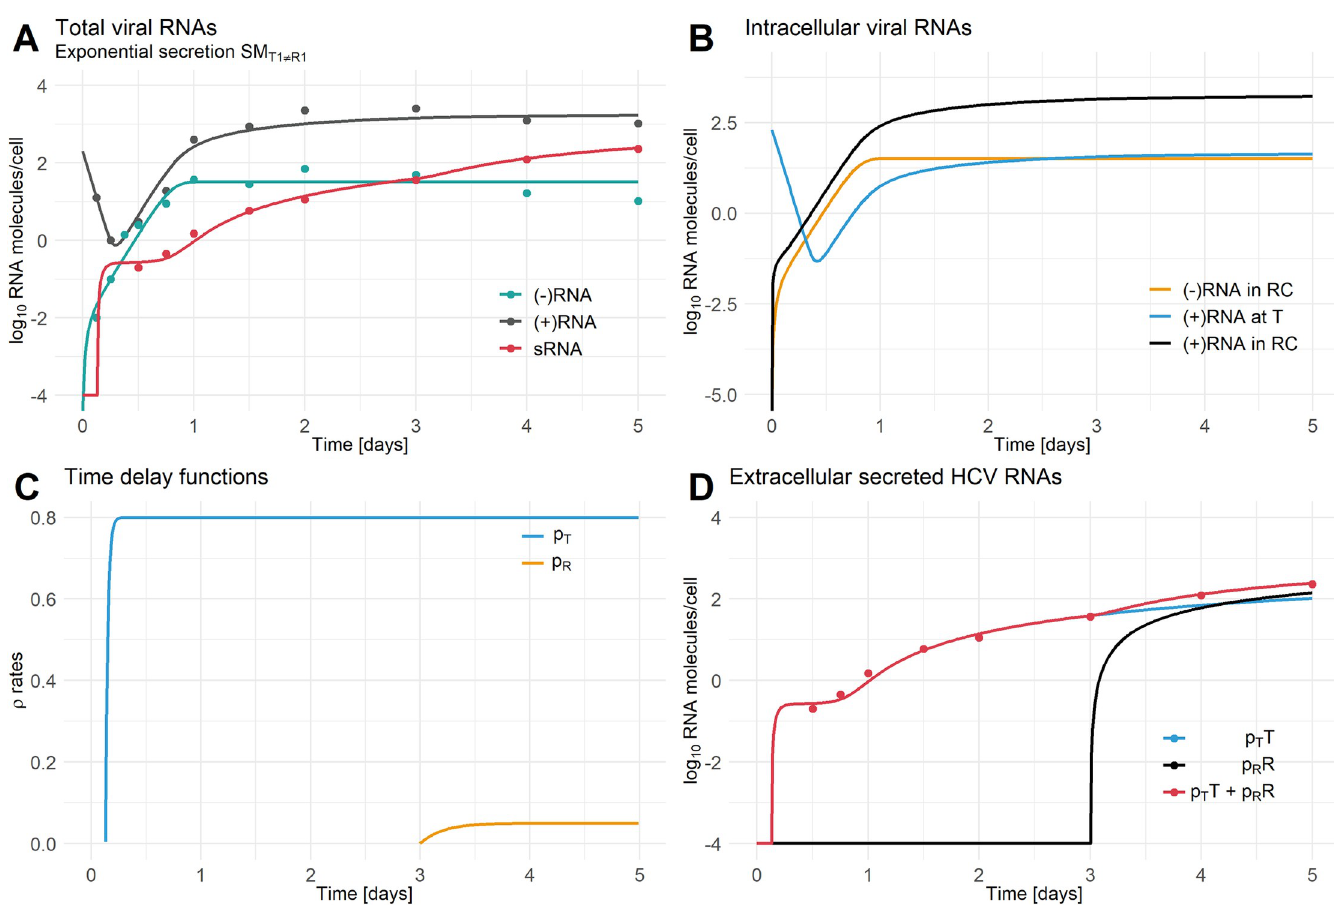
Fig 3. Individual HCV secretion from the site of translation and the replication compartment. A) Best-fit secretion model which includes independent HCV RNA secretion from the site of translation and the RC (SM T1 6¼ R1 with τ T = 0.1 d , τ R = 3 d , ρ T = 0.8 d − 1 , ρ R = 0.05 d − 1 , k T = 50 d − 1 , and k R = 5 d − 1 ). B) Intracellular HCV RNA species at the site of translation ( T ) and in the RC ( R ). C) Time delay functions for the HCV RNA secretion with ρ = (+)RNA secretion rate from site of translation and T ρ R = (+)RNA secretion rate from the RC. D) Composition of extracellular secreted HCV RNA with ρ T T denoting the amount of extracellular secreted (+)RNA from the site of translation, ρ R R denoting the amount of extracellular secreted (+)RNA from the RC and ρ T T+ρ R R denoting the sum of all extracellular secreted HCV (+)RNA species (sRNA). [(-)RNA = minus-stranded RNA, (+)RNA = plus-stranded RNA, sRNA = secreted HCV RNA (see S1 Data)]. Data has been taken from [35] Fig 1A–1C. See Table 4 for parameter